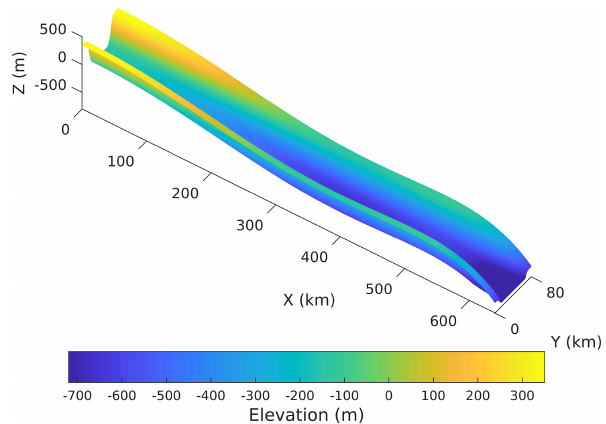
Figure 4. The bedrock topography for the MISMIP + experiment (Asay-Davis et al.,